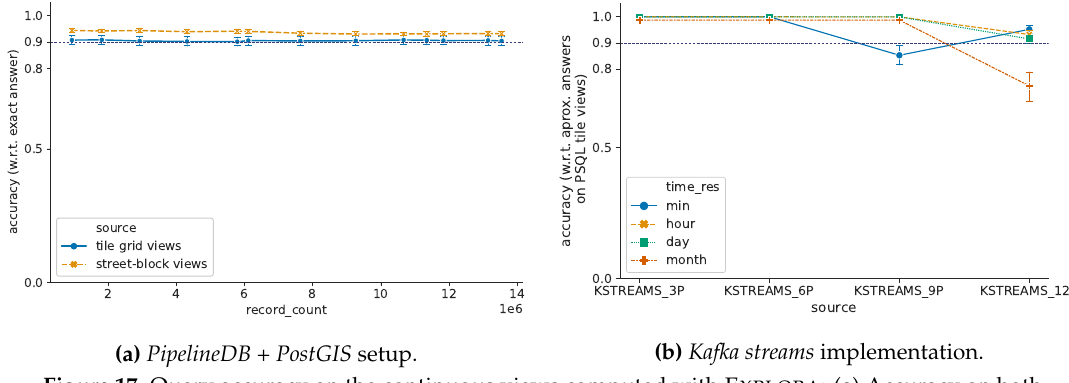
Figure 17. Query accuracy on the continuous views computed with E XPLORA : ( a ) Accuracy on both tile-grid and street-block views is above 90% on average. ( b ) Accuracy in relation to approximate answers from the PipelineDB + PostGIS setup: increasing the number of partitions eventually compromises query